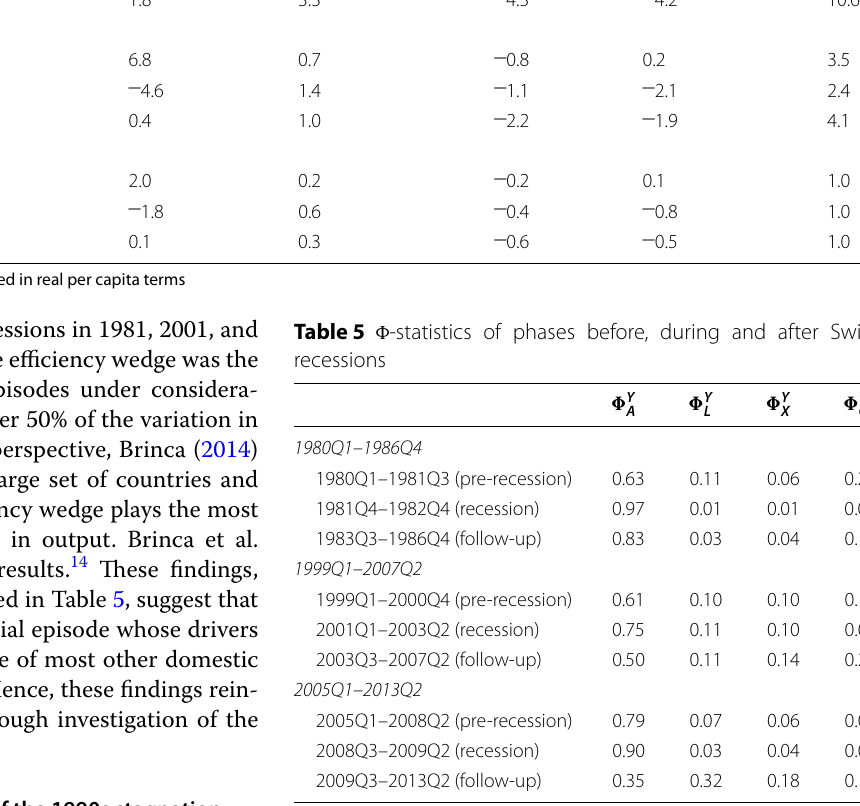
Table 4 Decomposition of real output movements (1987Q1–1996Q4)